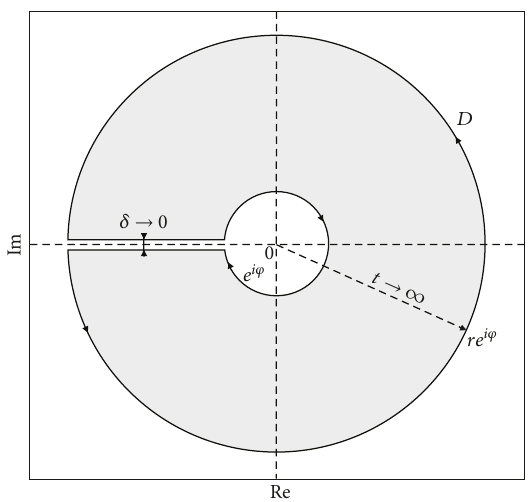
Figure 1: Simple closed positively oriented contour D